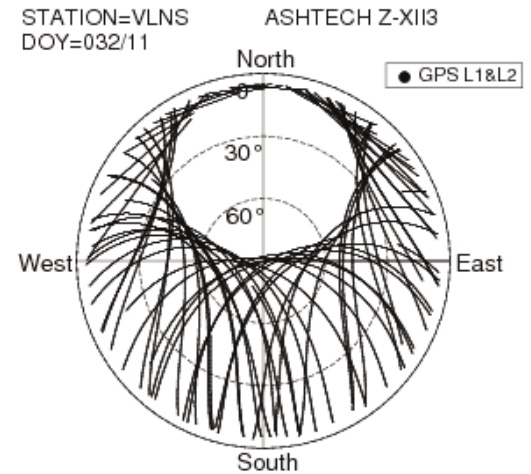
Fig. 4. Sky plot at VLNS station